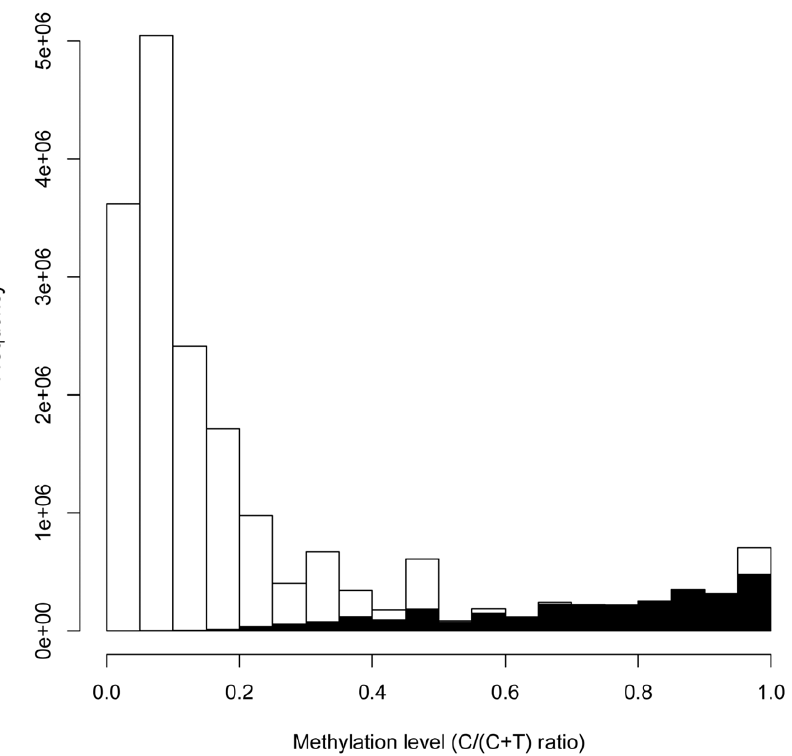
Figure 3. Global methylation level. Ratio of the number of mapped Cs divided by the number of mapped C plus T for all classified Cs. Black: Cs that are called methylated, White: C that are not called methylated.